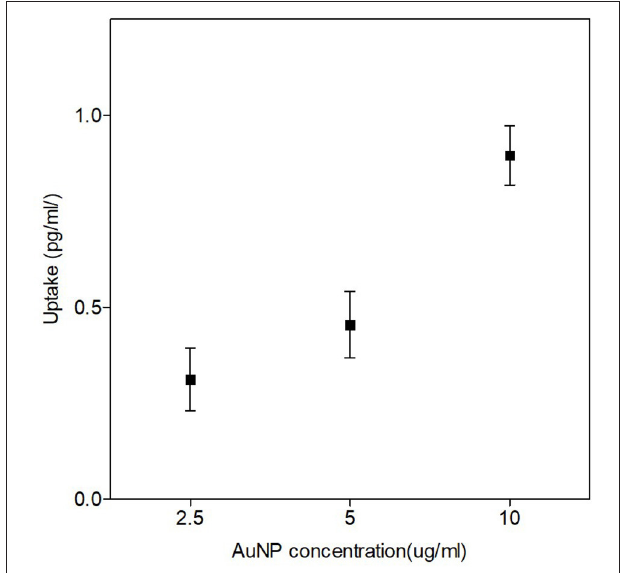
FIGURE 2 | Quantities of AuNP internalized per cell after a 4-hour incubation with different concentrations of 50nm AuNPs. ICP-MS results show the dose-dependent uptake of AuNPs. The highest internalization of 50nm AuNPs was observed at a concentration of 10 µ g/ml (37 µ M). The error bars represent the standard deviation of three biological replicates per concentration.